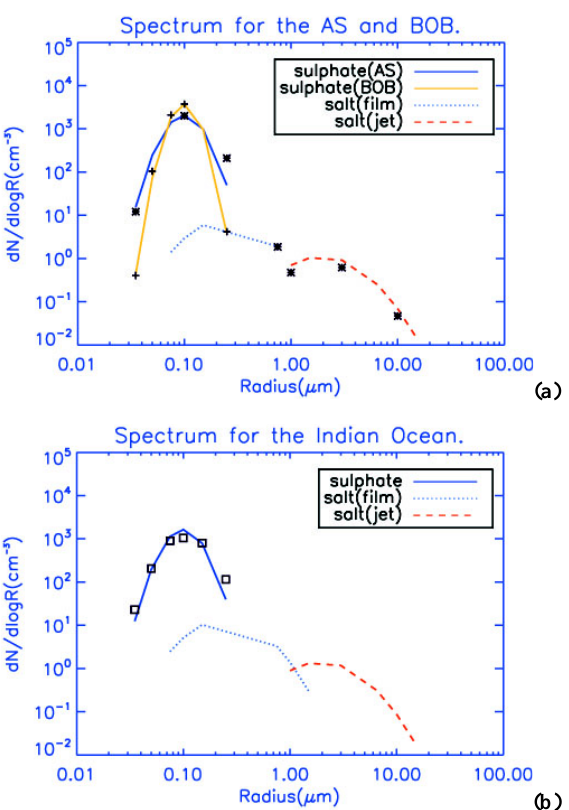
Fig. 1. Dry aerosol spectra for (a) AS and BOB ( ∗ and + represents the data observed by Jayaraman (2001) and Murugavel et al. (2008) respectively) and (b) Indian Ocean (represents the data observed by Murugavel et al., 2001). There were no observational data points for salt distributions for BOB and IO-wind-speed dependent estimates are